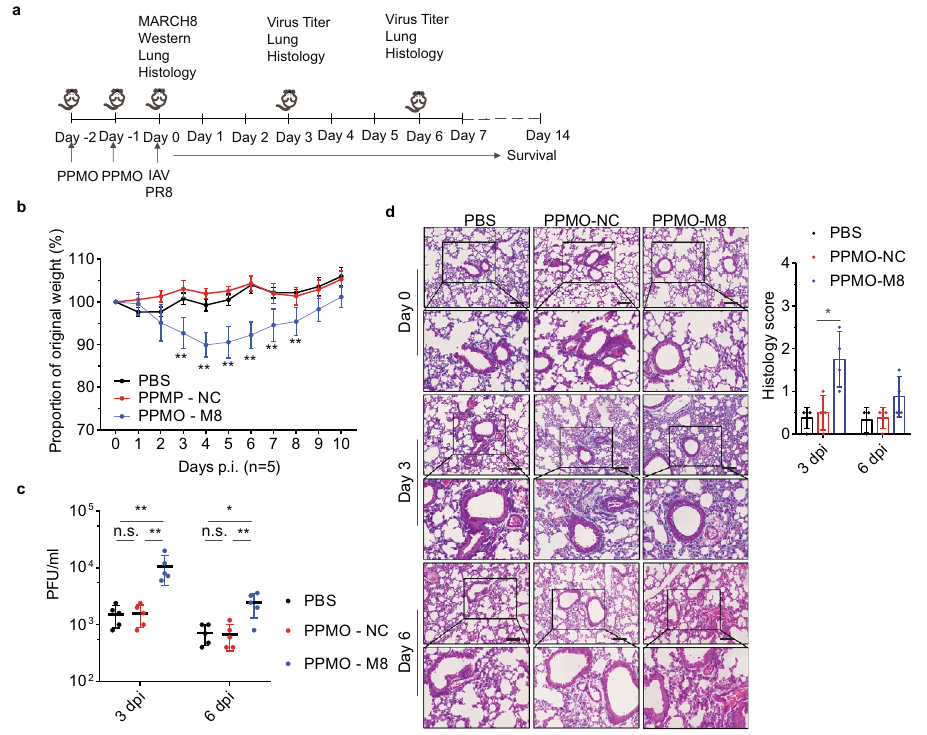
Fig. 3 MARCH8 inhibits IAV replication in vivo. Six-week-old male C57Bl/6 mice were administered PBS, control (PPMO-NC), or MARCH8 targeting PPMO (PPMO-M8) intranasally for 2 consecutive days. On day 0, two or three mice per group were killed before infection. Fifteen mice per group were infected with PR8 virus (200 PFU) intranasally on day 0. Five mice per group were euthanized on days 3 and 6 post infection. Bronchoalveolar lavage fl uid was collected to determine virus titer, and lungs were harvested to histopathology. In fi ve mice per group, survival was studied until day 14 post infection. a Diagram shows experimental plan. b Graph shows mouse body weight± SD ( n = 5 mice) up to 10 days post infection, for at least fi ve mice per group. c Graph shows mean lung virus titer ±SD ( n = 5 mice) on days 3 and 6 post infection. d Mouse lungs were isolated on day 0 (before infection), day 3, and day 6 post infection. H&E staining was performed on lung sections. Scale bars represent 200 μ m. Histological scoring is shown as mean ± SD ( n = 4 mice), * P < 0.01, ** P < 0.001, n.s., not signi fi cant, unpaired two-tailed Student t -test, without any adjustments for multiple